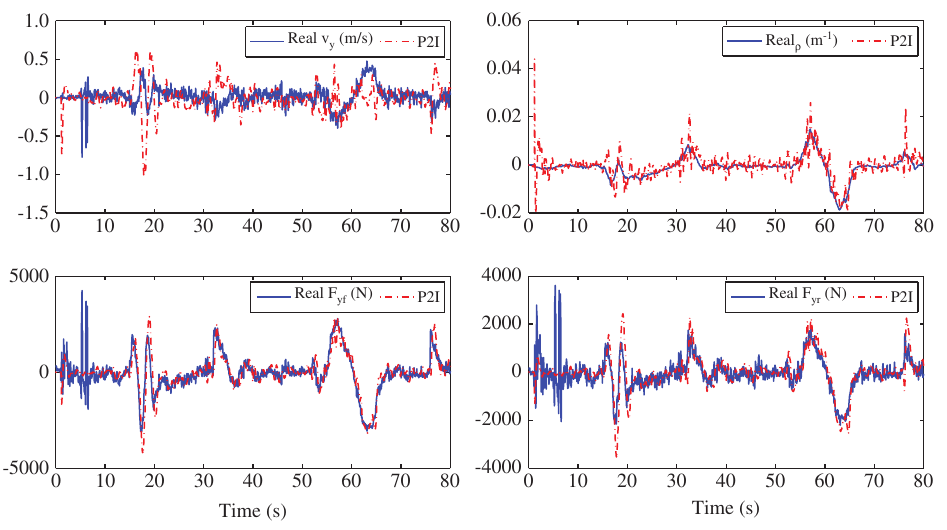
Figure 6. State Estimation with P2I (Real